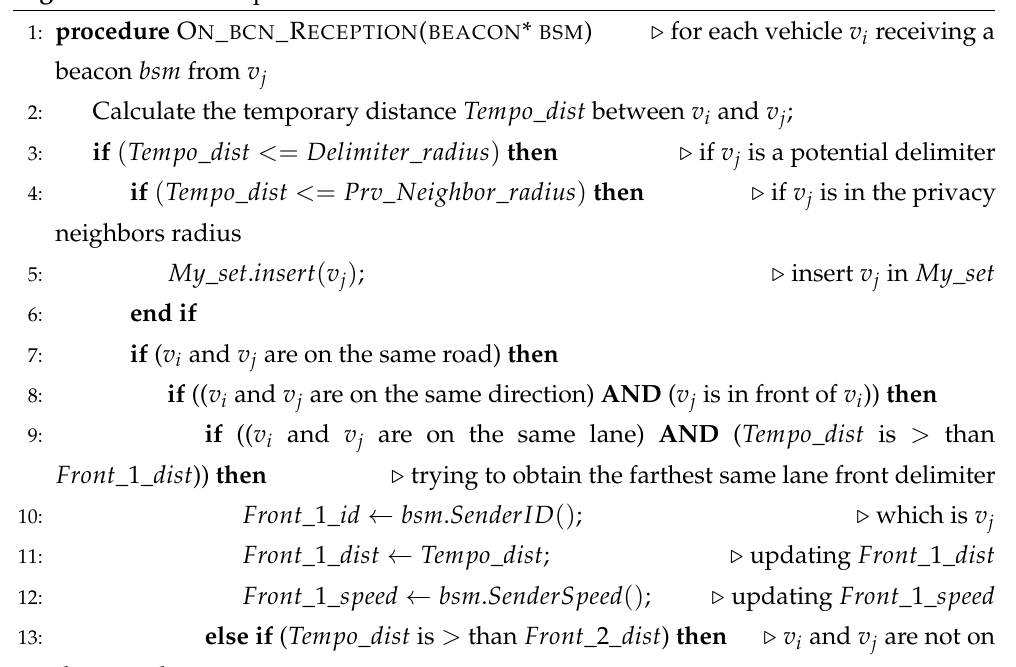
Algorithm 1 bcn